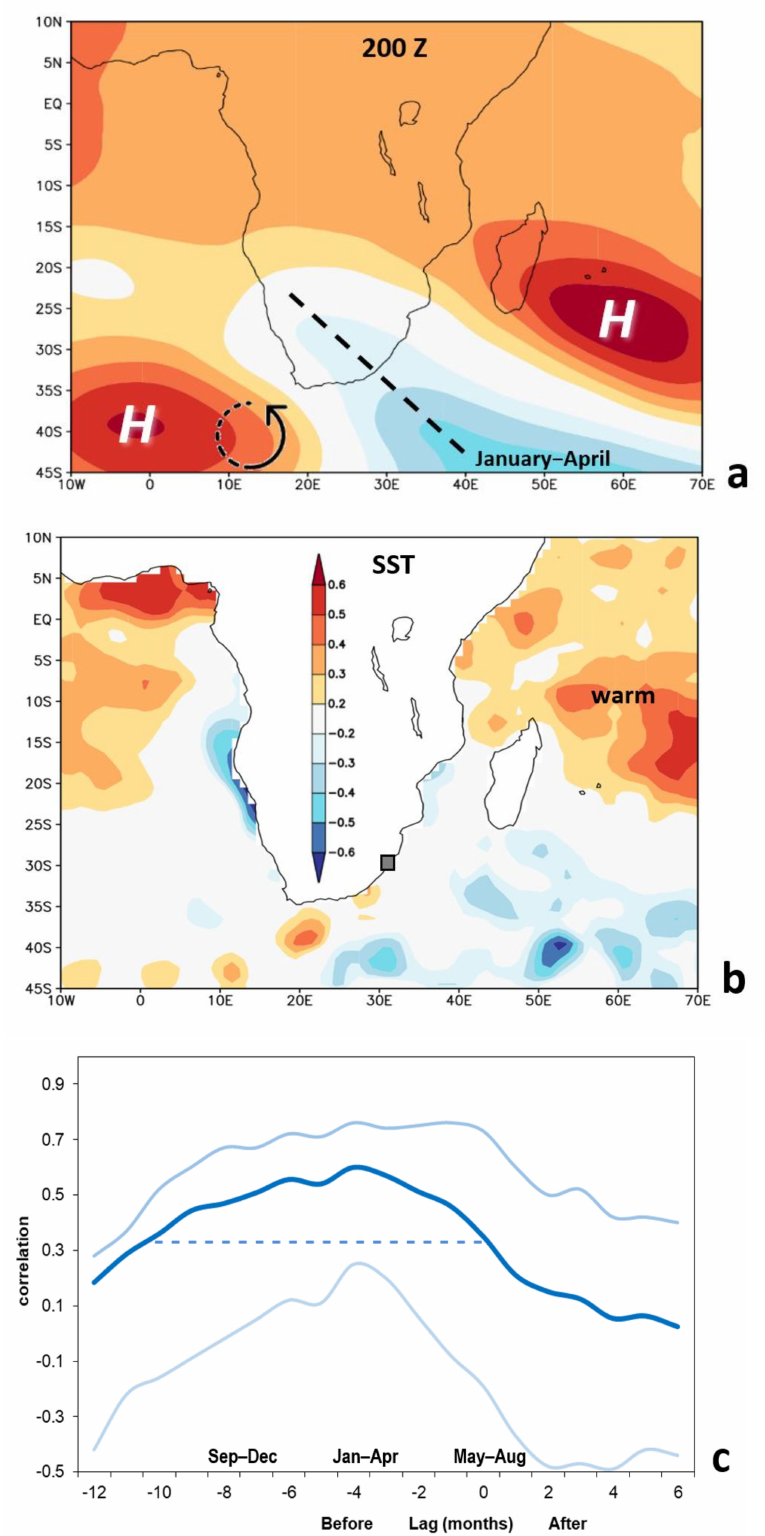
Figure 9. Point-to-field correlation of May − August air pollution index (cf. Figure 1e) with prior Jan − Apr: ( a ) ERA5 200 hPa geopotential height, anticyclonic spin behind dashed trough, ( b ) SST (at − 4 months) illustrating a warmer WIO leads higher pollution. ( c ) Lead/lag correlation of May − August air pollution index with WIO SST and terciles 2001–2020 with dashed 90% confidence threshold. Correlation color-bar for maps is given in ( b ), Durban is the grey